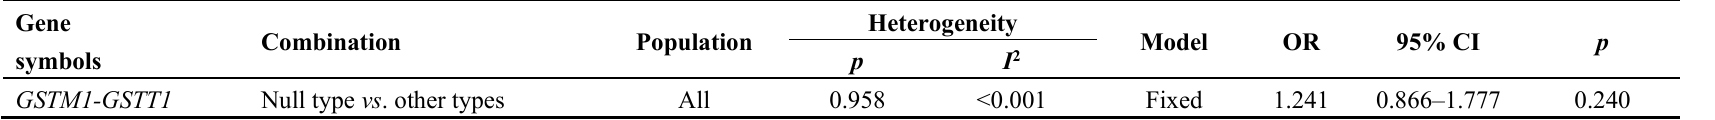
Table 3. Overall analysis between combination of glutathione S -transferase genes ( GSTM1 and GSTT1 ) and susceptibility of schizophrenia. Gene